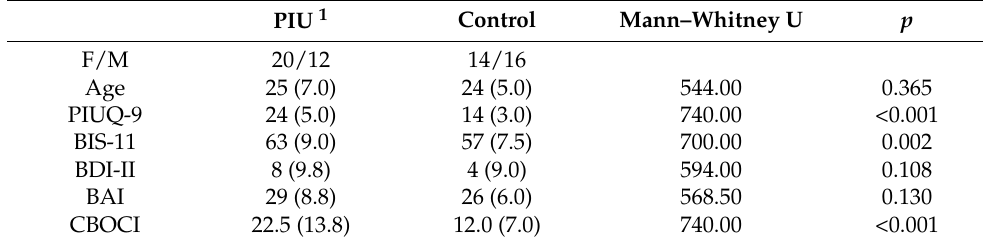
Table 1. Demographic and psychological characteristics of the study